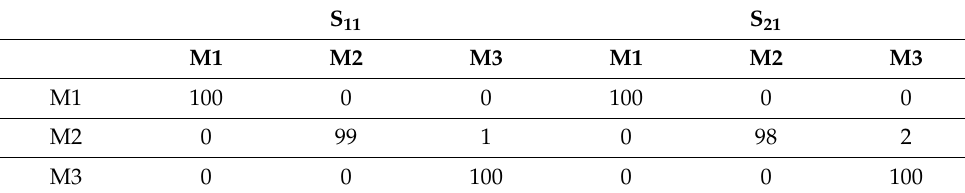
Table 6. Confusion matrix with detailed fault classification result using GBDT.